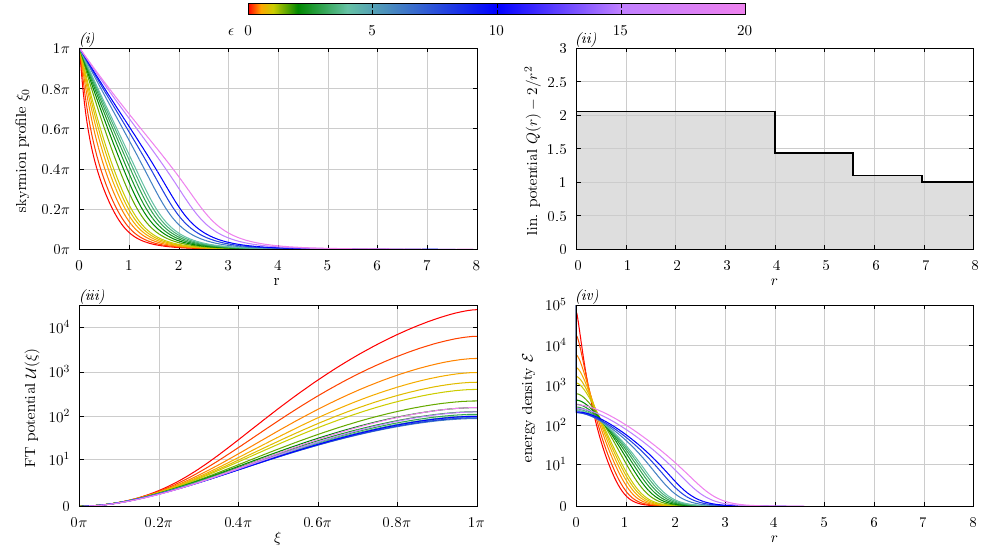
for the full Skyrme model . (i) U L 0246 ; (iv) the energy densities. The structure of U